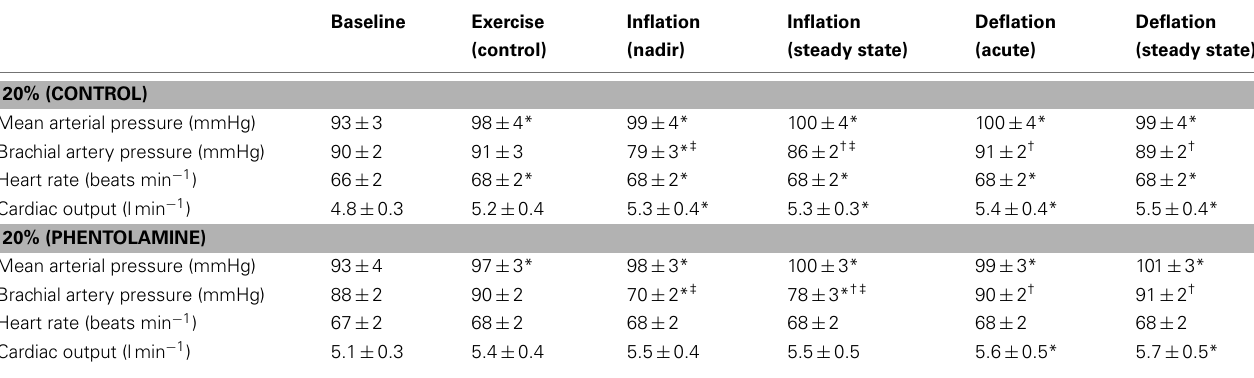
Table 2 | Systemic hemodynamic responses ( n =